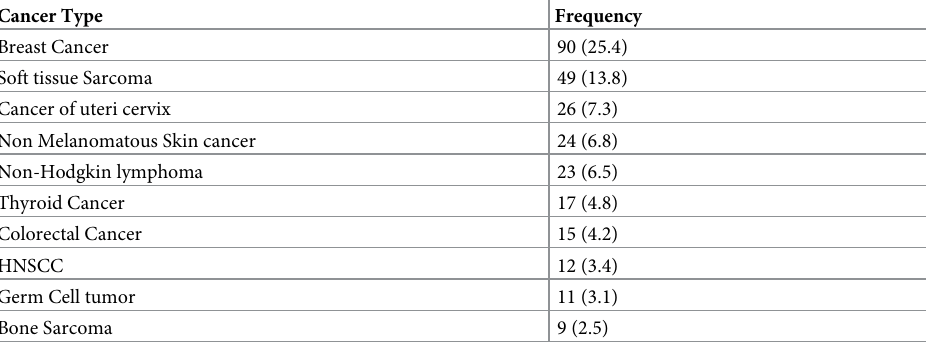
Table 2. Commonest cancer